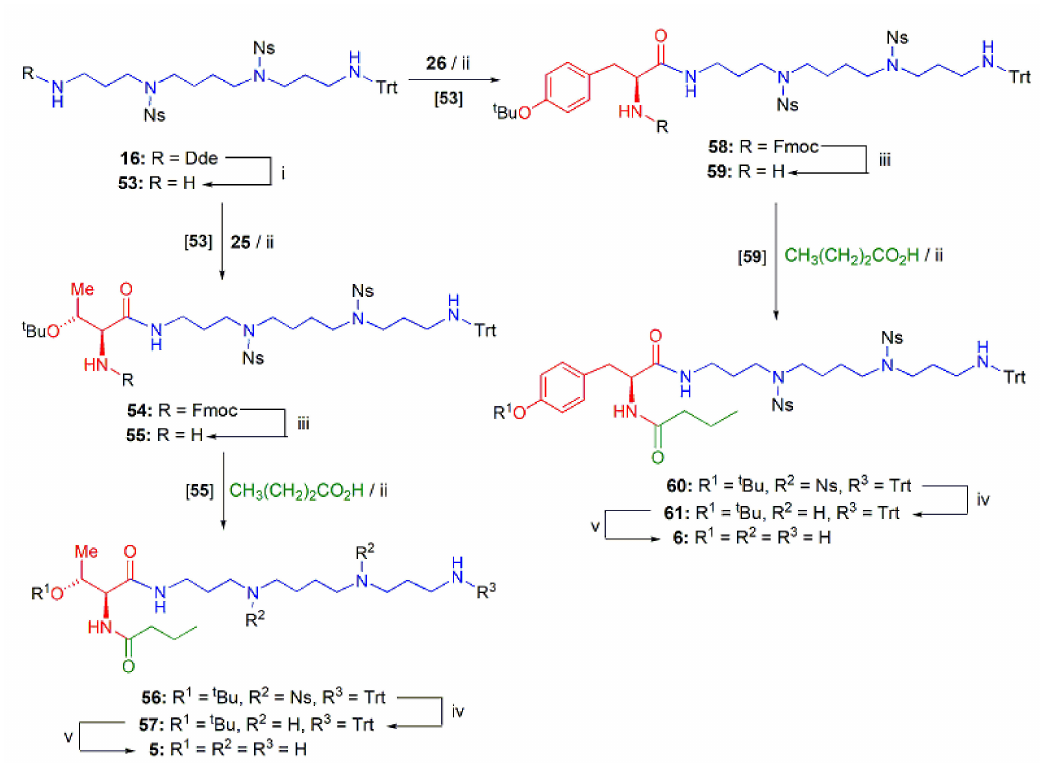
Scheme 4. Outline of synthetic routes to PAT analogues 5 and 6 . Reagents and conditions : (i)